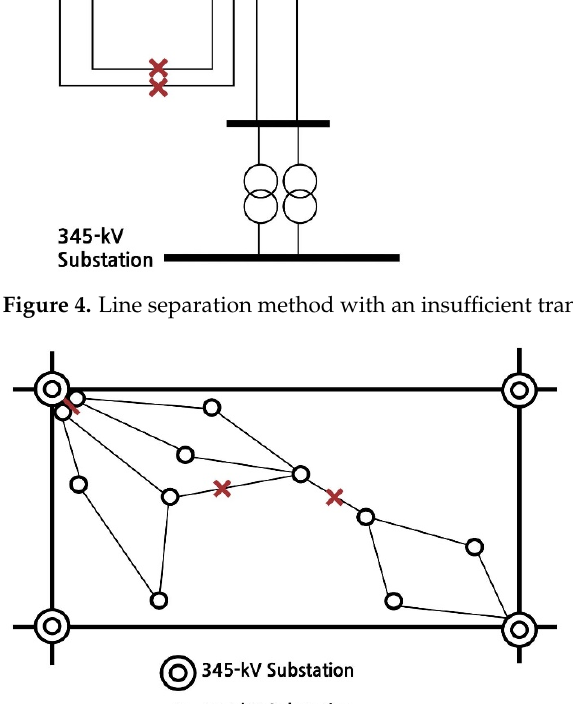
Figure 5. Bus and line separation method for reducing the short-circuit current.